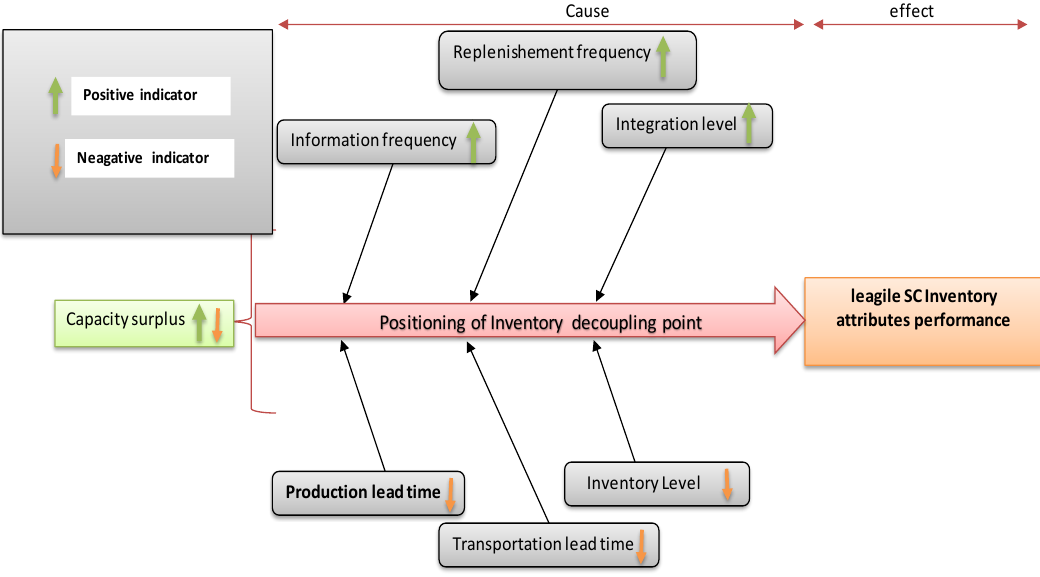
Figure 5. Leagile SC inventory attribute cause and effect